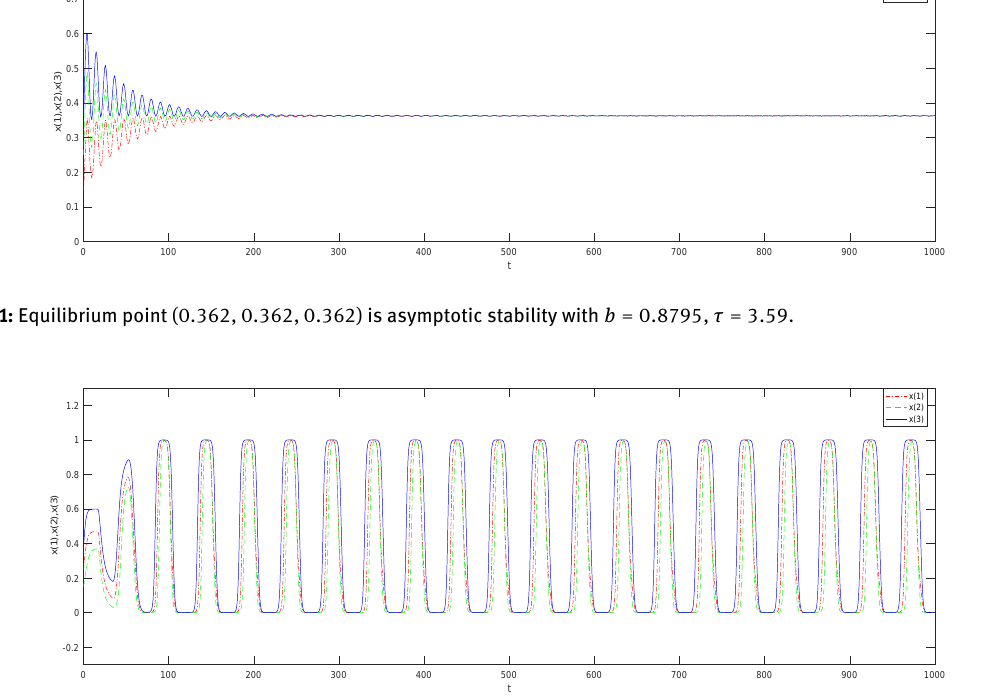
Figure 2: Trajectories x (1), x (2) and x (3) of system (1.1) with b = 1.0009, τ = 16.9